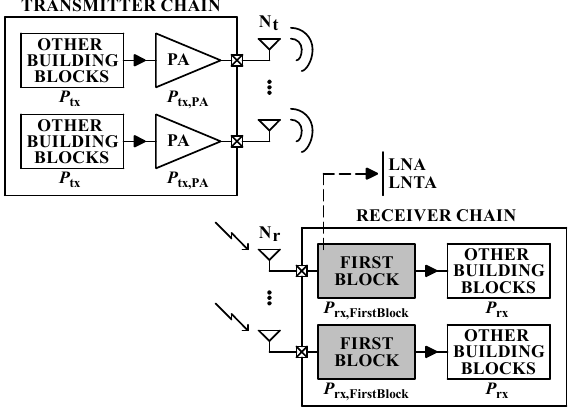
Figure 3. RF transceiver building